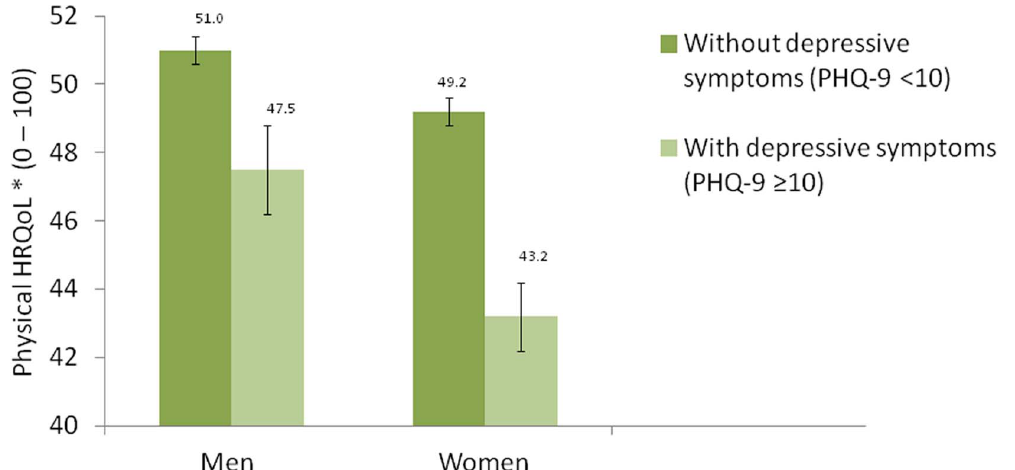
Figure 1. Physical health related quality of life (Physical HRQoL, bars) and their 95% confidence intervals in participants with depressive symptoms (PHQ-9 $ 10, 111 men and 228 women) and without depressive symptoms (PHQ-9 , 10, 7,196 men and 8,492 women) by sex. *Adjusting for age, education level, drinking status, physical activity level, body mass index, number of chronic diseases, life stress, neighborhood cohesion, household monthly income and the number of person in a household.